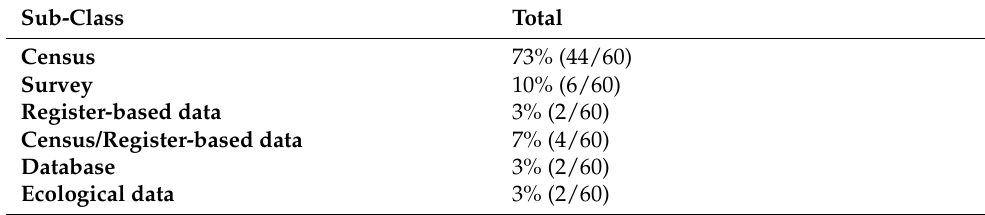
Table A2. Sources of data used to create the deprivation